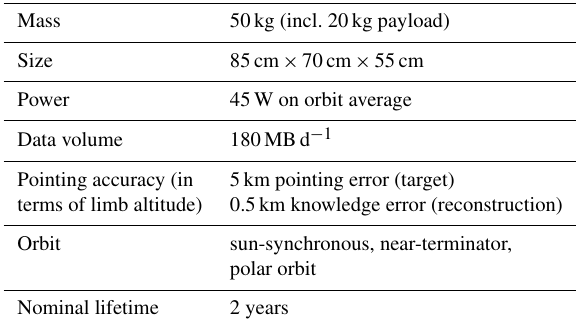
Table 2. Selected parameters of the InnoSat satellite platform in its baseline